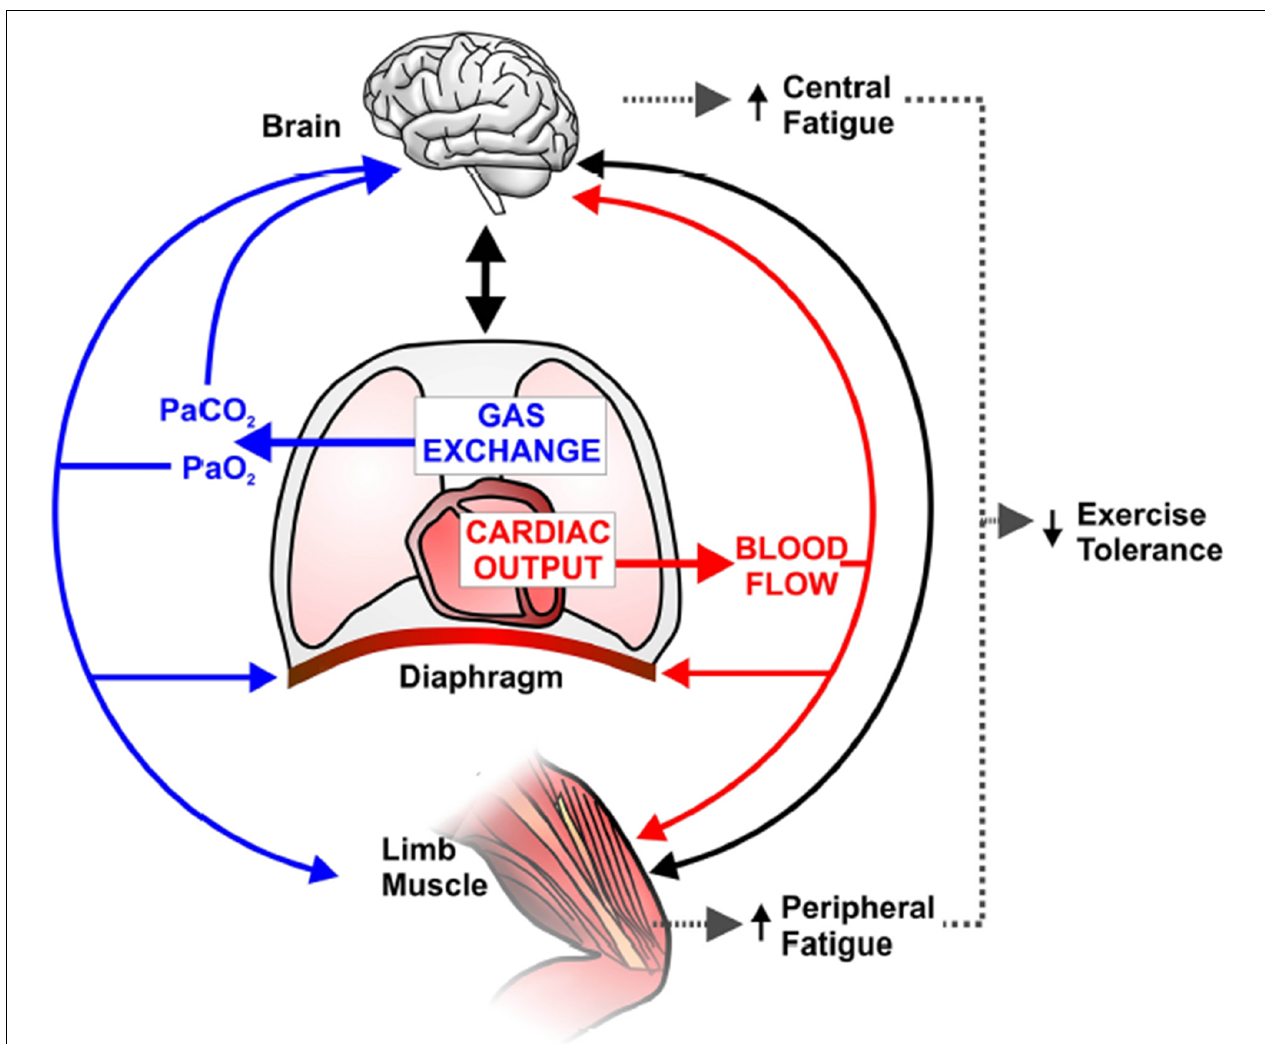
FIGURE 5 | Schematic representation of potential implications of abnormal pulmonary gas exchange and central hemodynamics on central nervous system (brain) and peripheral skeletal muscle function during exercise in combined chronic obstructive pulmonary disease-heart failure. Compromised O 2 delivery to the brain and active limb muscles can occur as a consequence of impairments in gas exchange (e.g., a reduction in arterial O 2 pressure; PaO 2 ) and/or decreased cardiac output and thus blood flow. A large fraction of an already reduced cardiac output can be directed to the overloaded respiratory muscles (due to increased work of breathing), therefore further decreasing active limb muscle perfusion and accentuating peripheral fatigue. Solid blacklines indicate that increased afferent information from the respiratory and peripheral muscles and/or impaired cerebral oxygenation may decrease motor drive (i.e., central fatigue). In this context, it is conceivable that central and peripheral fatigue potentiate each other and contribute to early exercise cessation in coexistent COPD-CHF. Reproduced and modified, with the permission of the publisher from: Oliveira et al.